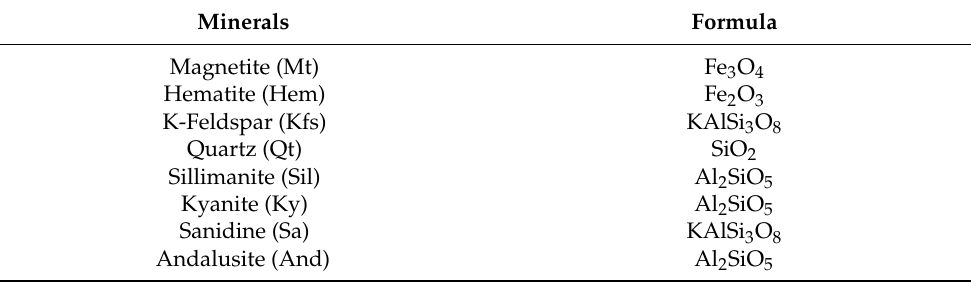
Table A4. Pure minerals included in the modeling of typical and “oxidized” pelite. The thermody- namic properties of the pure minerals are from Holland and Powell